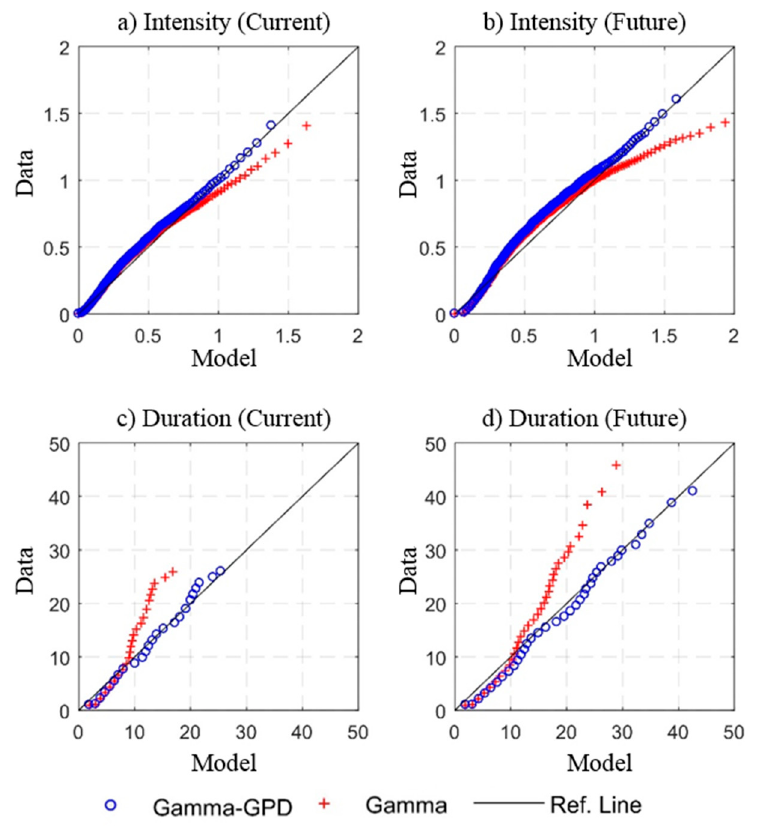
Figure 8. QQ plot of ( a ) the current and ( b ) future drought intensity (in million cubic meter), and ( c ) the current and ( d ) future drought duration (in month) for the mixture model versus gamma.